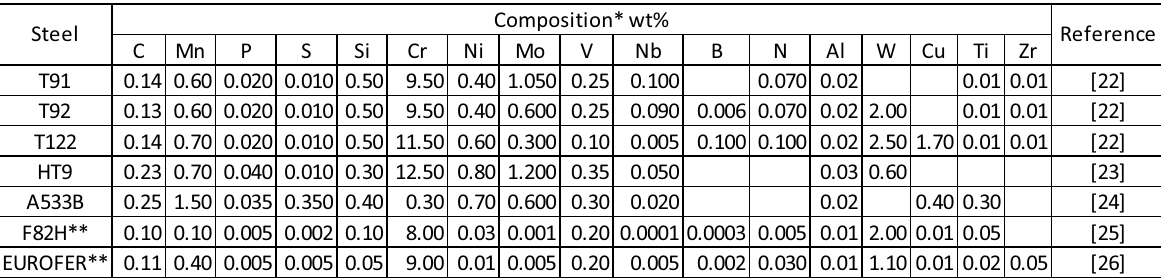
* Balance Fe ** Additional impurities listed in